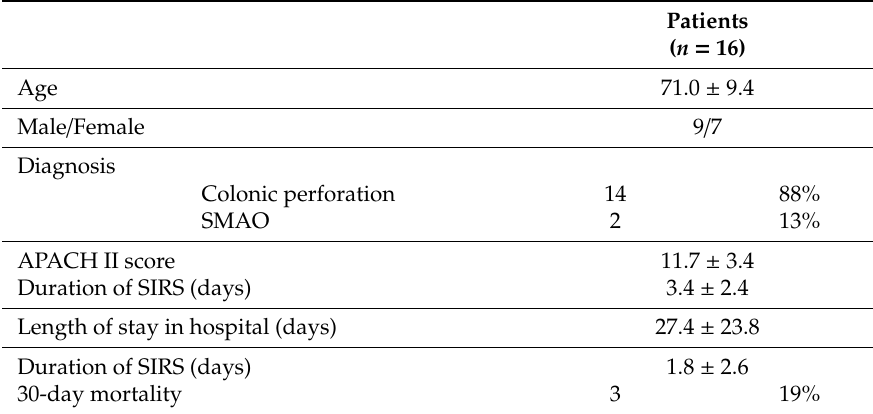
Table 1. Demographic data of patients with